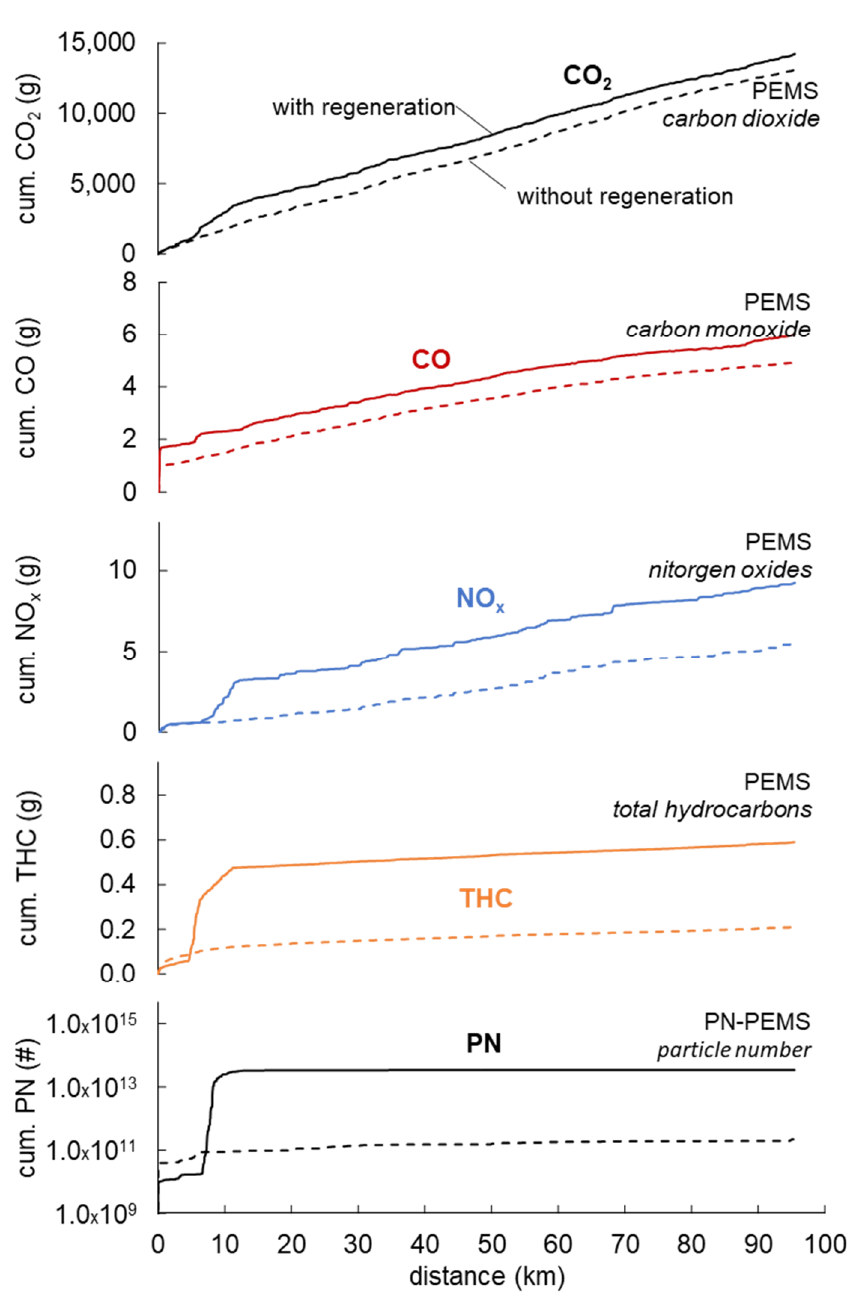
Figure 3. Example of cumulated emissions of the diesel, vehicle 2, in summer with DPF regeneration, official RDE route.